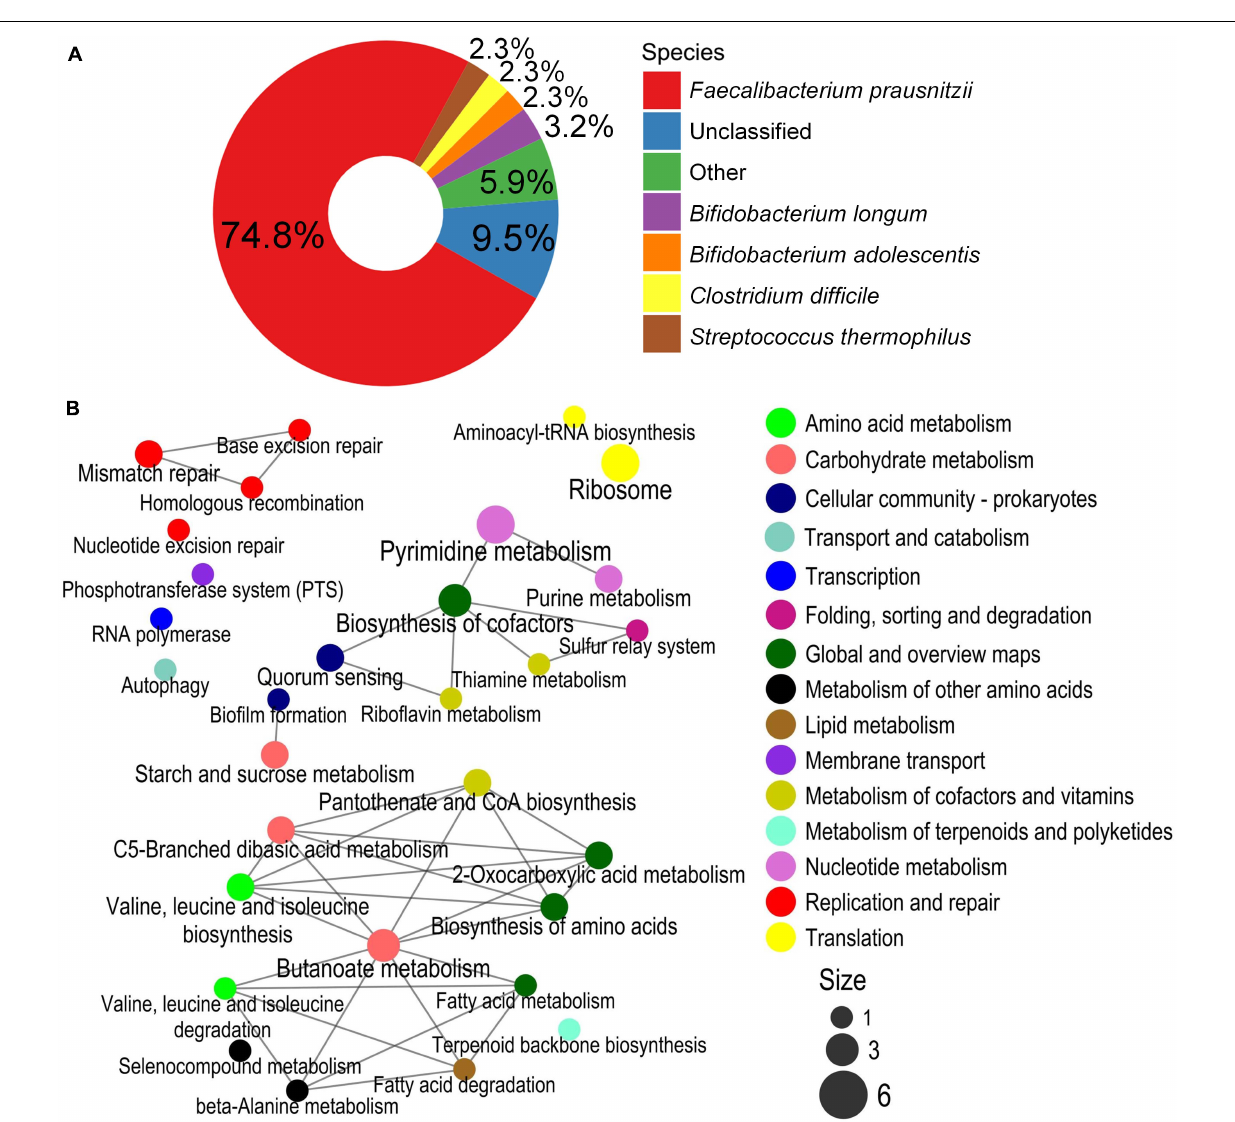
FIGURE 5 | Species composition and enrichment metabolic pathways carrying the BiasSNPs in SO children. (A) Composition of species with BiasSNP in PWS children. Colors represent different species. (B) The relationship between the metabolic pathways of BiasSNP in PWS children. The line indicates that the metabolic pathways share the same gene, the dot represents the pathway, the size of the dot represents the number of genes with BiasSNP in the pathway, and the color represents the class of